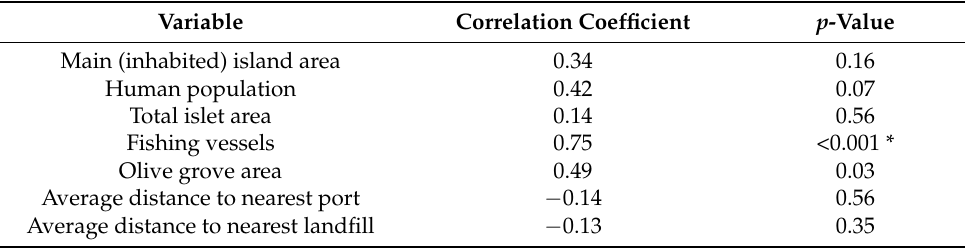
Table 3. Pearson’s correlation coefficients between regional variables and the total number of nesting pairs in a region. Those marked with an asterisk (*) are significant with a p -value less than 0.007. Variable Correlation Coefficient p -Value Main (inhabited) island